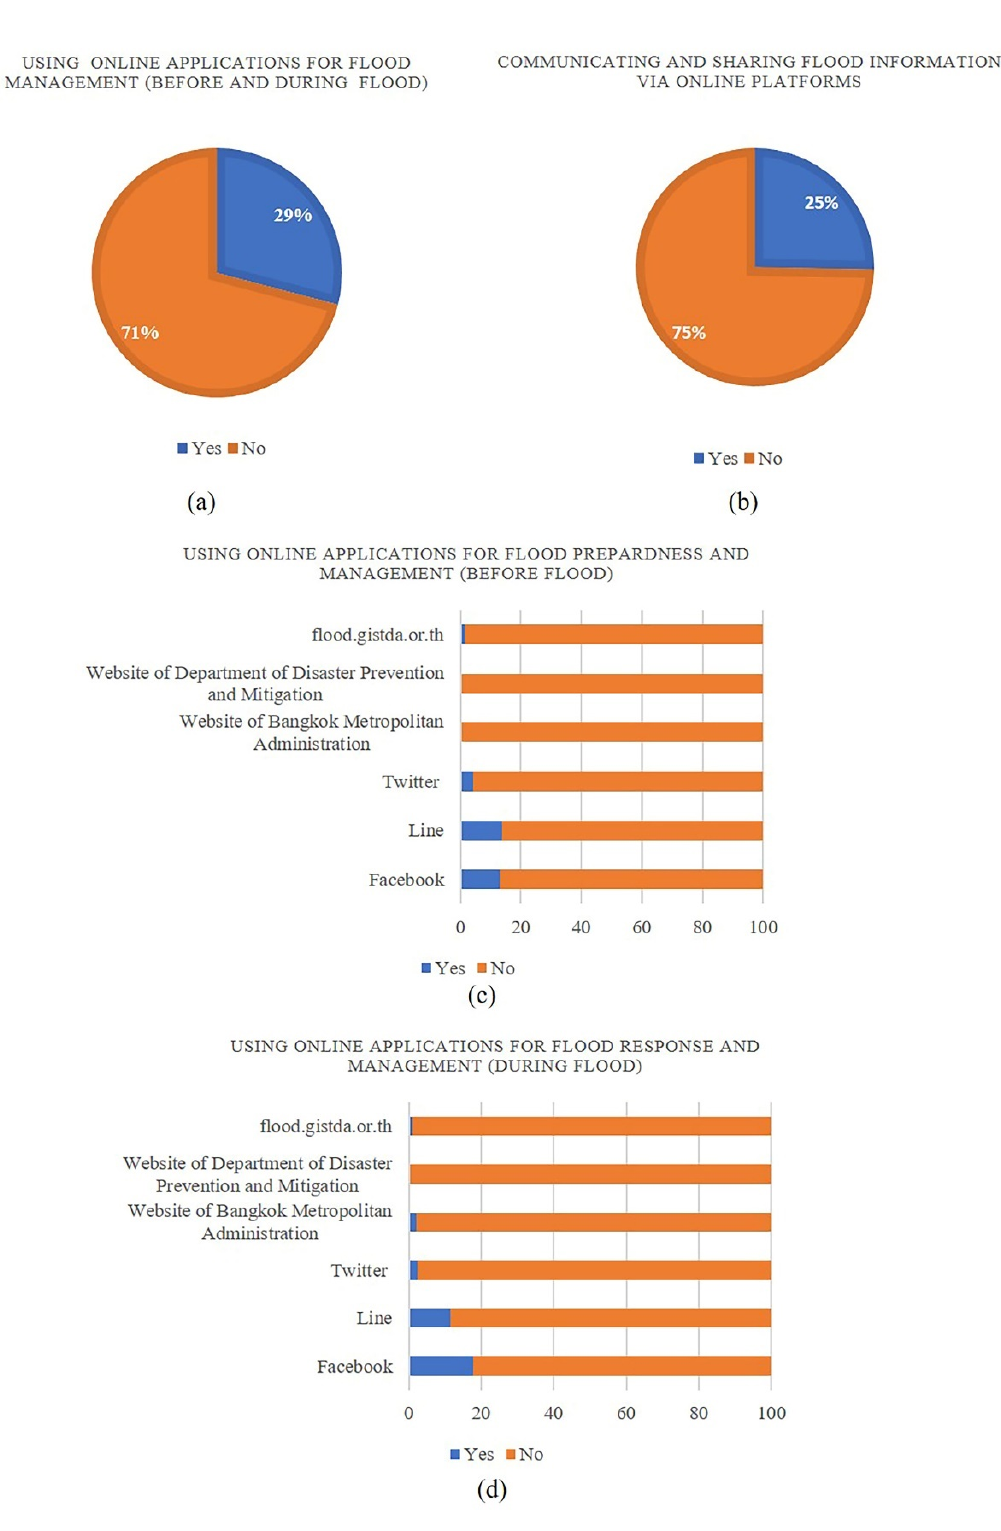
Figure 6. Experiences in using web-based applications in flood management both ( a ) before and ( b ) during flood disaster, and ( c ) lists of open-source web applications for flood preparedness (before flood) and ( d ) flood response and management (during flood) (n = 736).